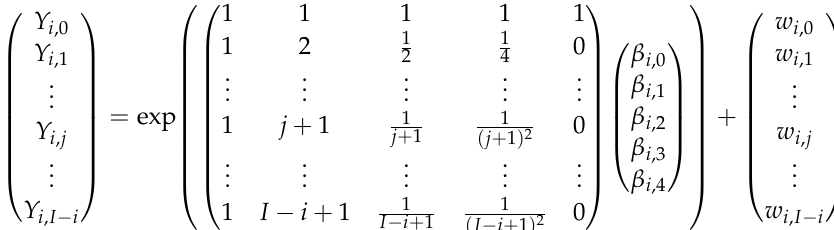
with respect to the development year j = 0, . . . , I . Here, δ j ,0 denotes the Kronecker delta ,